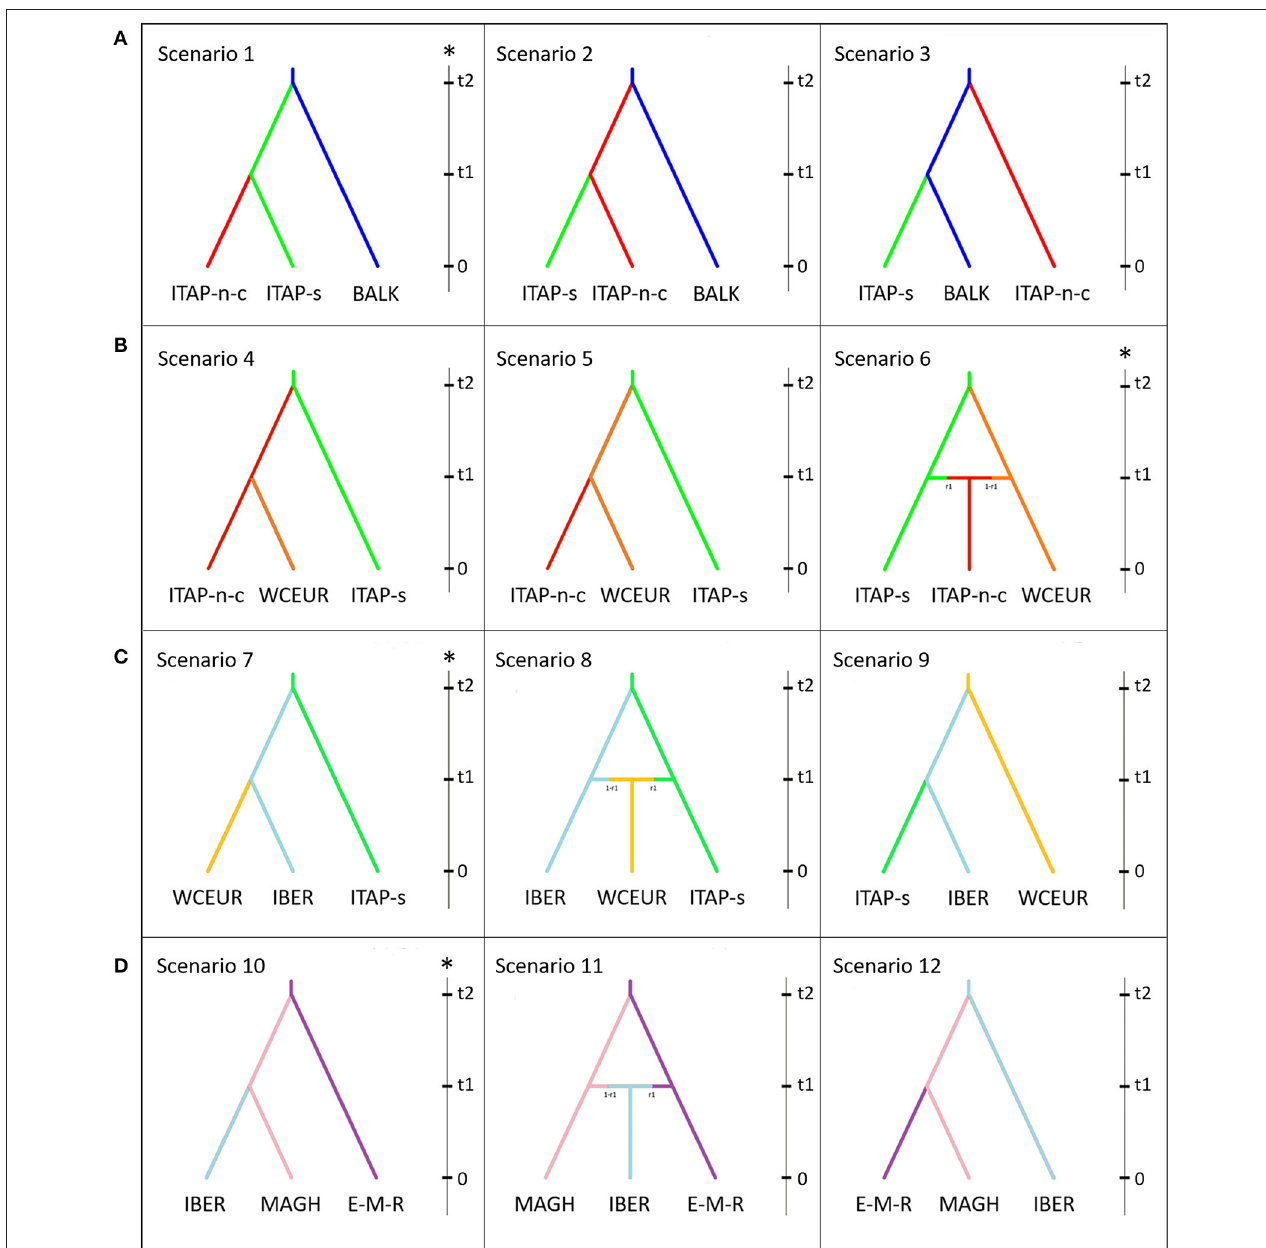
FIGURE 6 | Schematic representation of scenarios depicting the grapevine gene flow in the Mediterranean basin, based on ABC approach. Scenarios were depicted to validate or rebut the gene flow. (A) from Balkans to Northern Italy, (B) from ITAP-south to Western and Central Europe, (C) from ITAP-south to WCEUR through IBER, and (D) from Middle and Far East to IBER through Northern Africa. The vertical bar in each box indicates the timescale ( t 2 > t 1 > t 0 ; t 0 = present). For each hypothesis, the most likely scenario (*) was selected among the ones showing: (i) the highest values of logistic regression; (ii) the lowest number of outlying statistics; (iii) the highest value of posterior probability; (iv) the highest value of performance evaluation; (v) the mean values of Types I–II error lower than 20%, indicating an adequate power and sensitivity of ABC analysis (Chen et al., 2017). The samples named EMCA-MFEAS-RUUK (Table 1) was indicated as E-M-R, while ITAP-north-center and ITAP-south was named, ITAP-n-c and ITAP-s, respectively. ABC, approximate Bayesian computation; EMCA-MFEAS-RUUK; Eastern Mediterranean and Caucasus, Middle and Far East, Russia and Ukraine; ITAP-south, ITAP-Southern Italy; ITAP-north-center, ITAP-Northern, and Center Italy; WCEUR, Western and Central Europe.